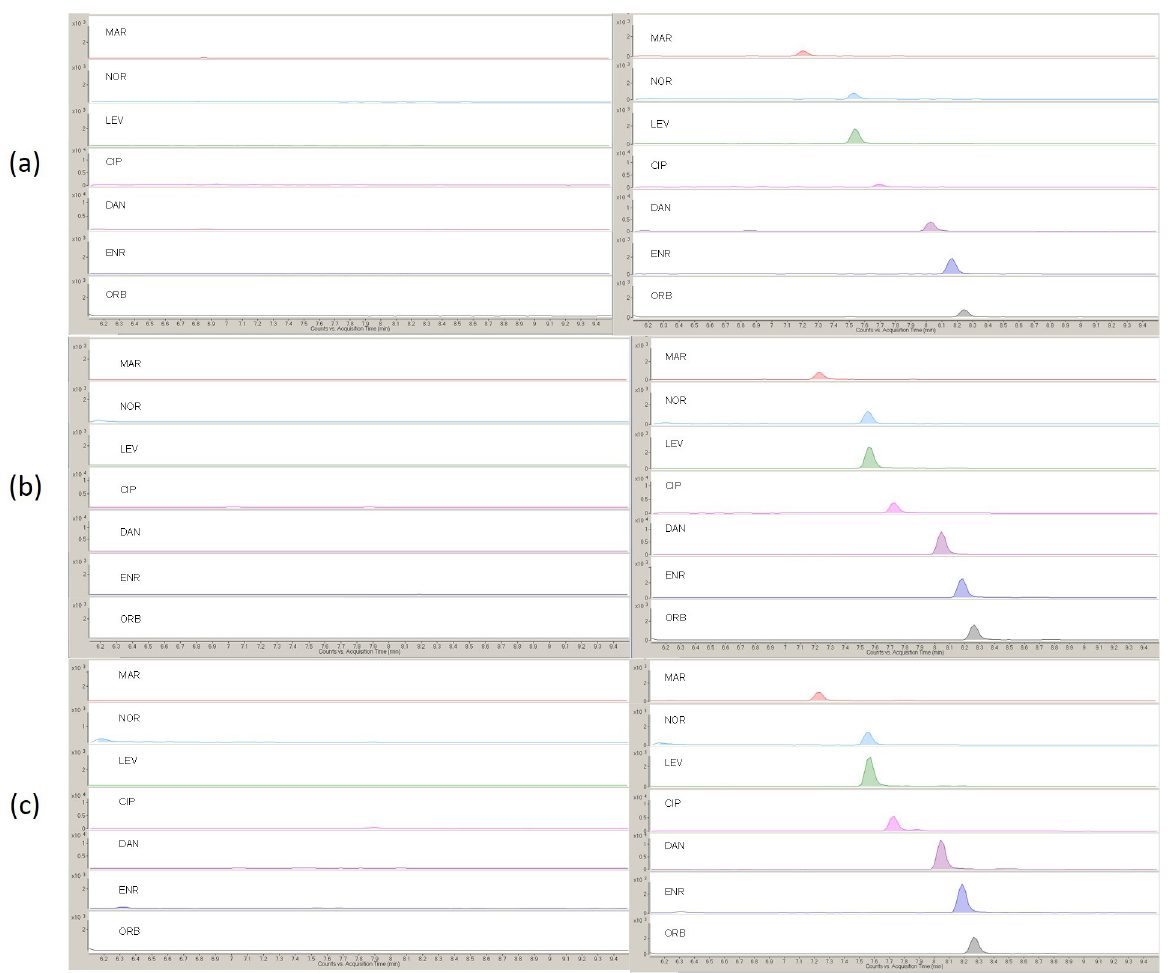
Figure 2. MRM chromatograms of blank sample extract and spiked sample extract (2.5 ng mL − 1 ) from ( a ) spinach, ( b ) lettuce, ( c ) cucumber.